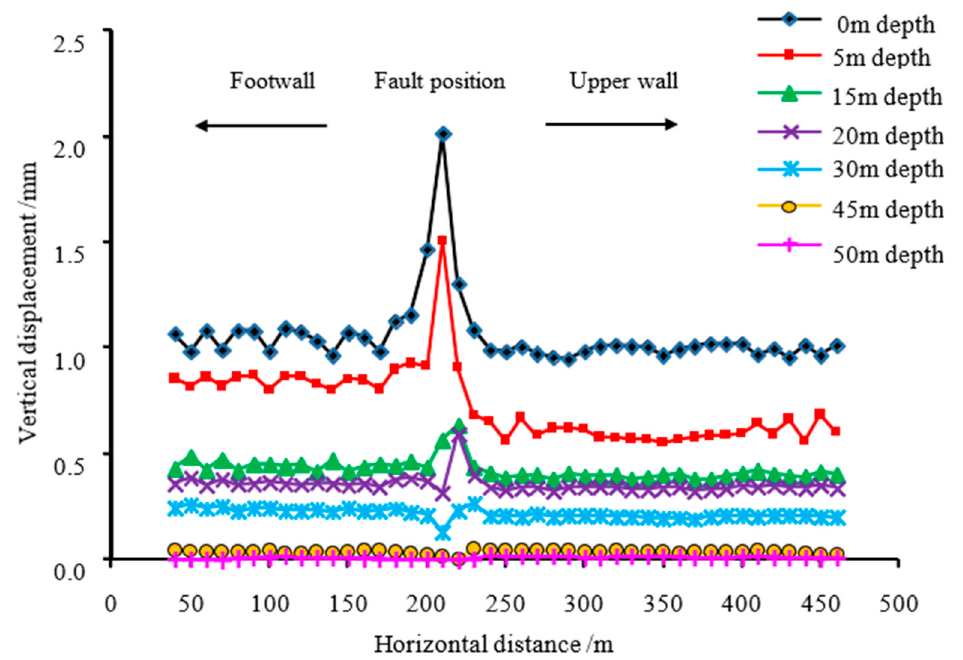
Figure 9. Distribution curves of vertical displacement at different depths along the high-speed railway line at the speed of 200 km/h.